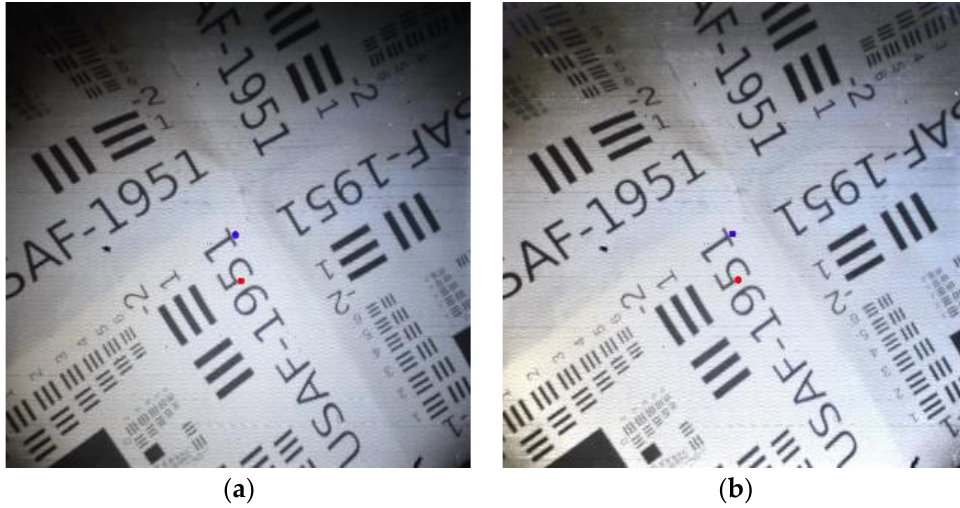
Figure 4. Images before and after processing. ( a ) Image before processing; ( b ) image after processing.